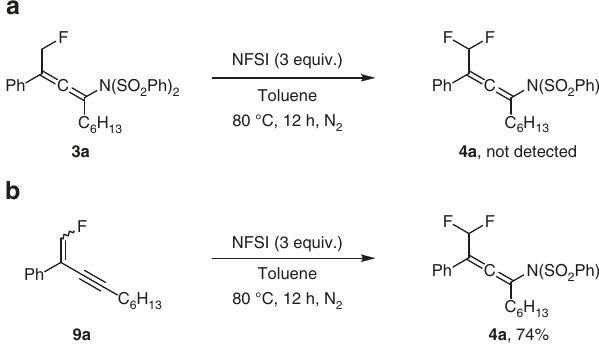
Fig. 4 Mechanistic studies. a Test of 3a as the possible reactive intermediate. b Test of 9a as the possible reactive intermediate.